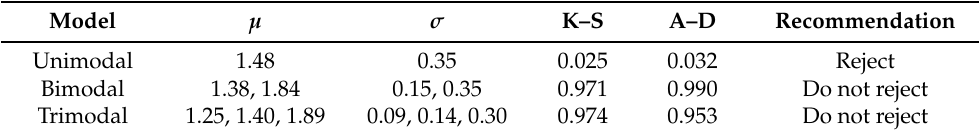
Table 1. p -value of two hypothesis tests for three different models.